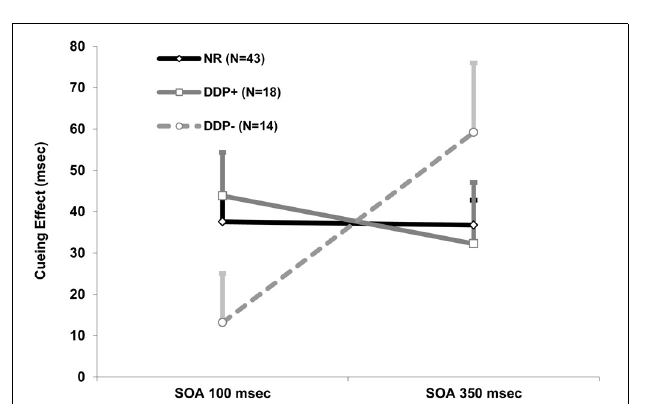
FIGURE 4 | Mean of cuing effect (i.e., invalid – valid RT differences) and standard error as a function of cue-target stimulus onset asynchrony (SOA; 100 and 350ms) and group (NR, DDP + , and DDP − ).